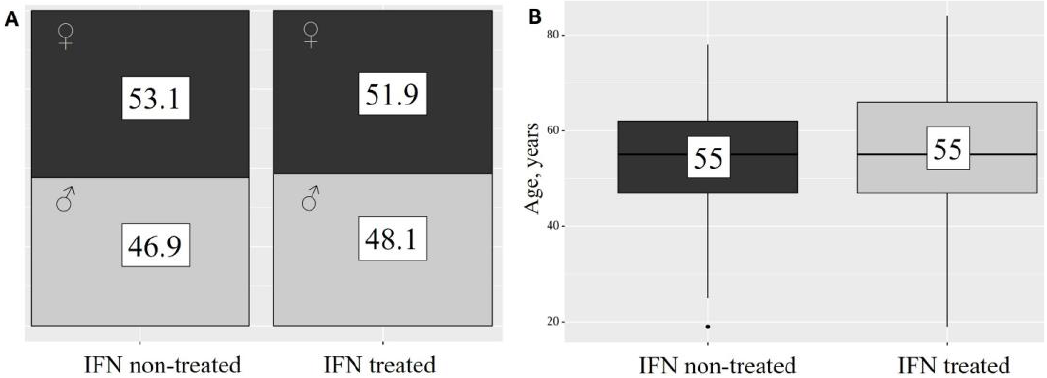
Figure 1. Patient characteristics. Distribution of sex ( A ) and age ( B ) within the non-treated (dark grey) and treated (light gray) patient groups.